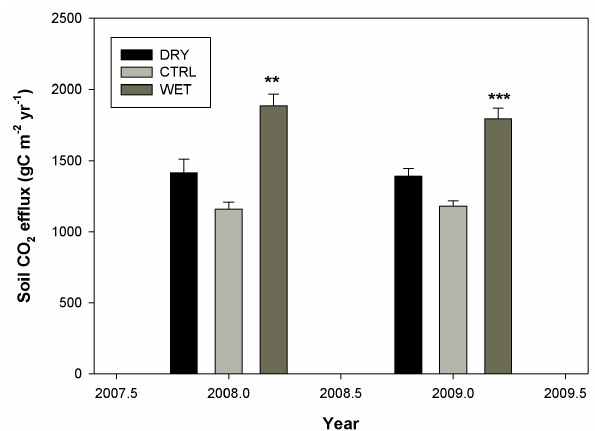
Fig. 5. Cumulative annual soil respiration in the control, dry and wet plots for the 2008 and 2009. Data are means ( n = 3) with bars as standard error. ** = P < 0 . 01; *** = P < 0 .